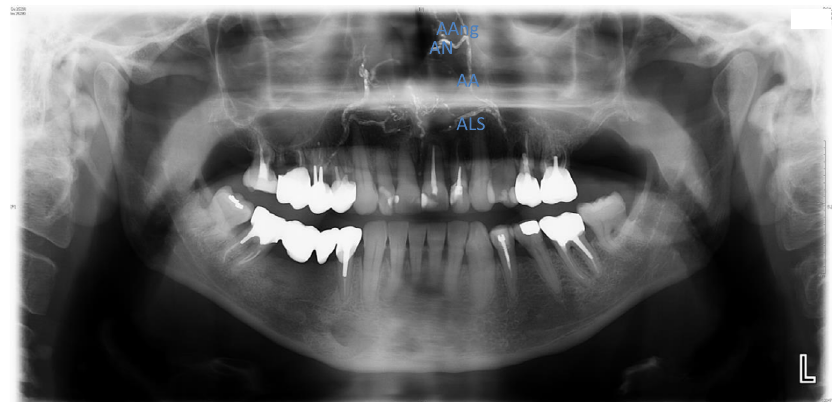
Fig. 1. Orthopantomogram: bilateral embolization in the facial artery territory. The path of the facial artery collaterals stand out because of the radio-opaque embolization microspheres: (a) superior labial arteries (ALS), (b) alar arteries (AA), (c) nasal arteries (AN), (d) angular arteries (AAng). Imaging of Pr A. Bonafé.